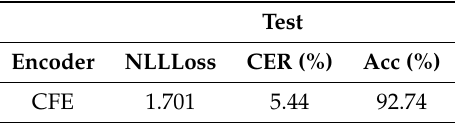
Figure 11. Evolution of the training (red) and validation (blue) errors (NLLLoss) for the proposed CFE encoder using dataset E3. In this case, the horizontal scale represents the number of iterations. The training time was 22 h. Table 8. Results obtained by the proposed CFE encoder for the third experiment (E3). Encoder: Name of the encoder used. NLLLoss: Negative log-likelihood loss. CER: Character error rate. Acc (%): Accuracy. Test